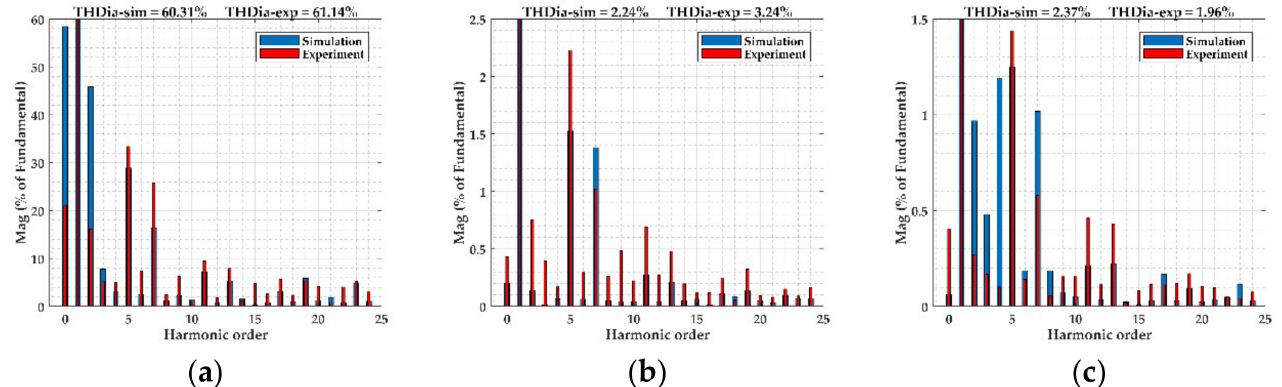
Figure 10. Comparison of simulation and experimental results using THD Ia factor for three different cases: ( a ) Low irradiance case; ( b ) medium irradiance case; ( c ) high irradiance